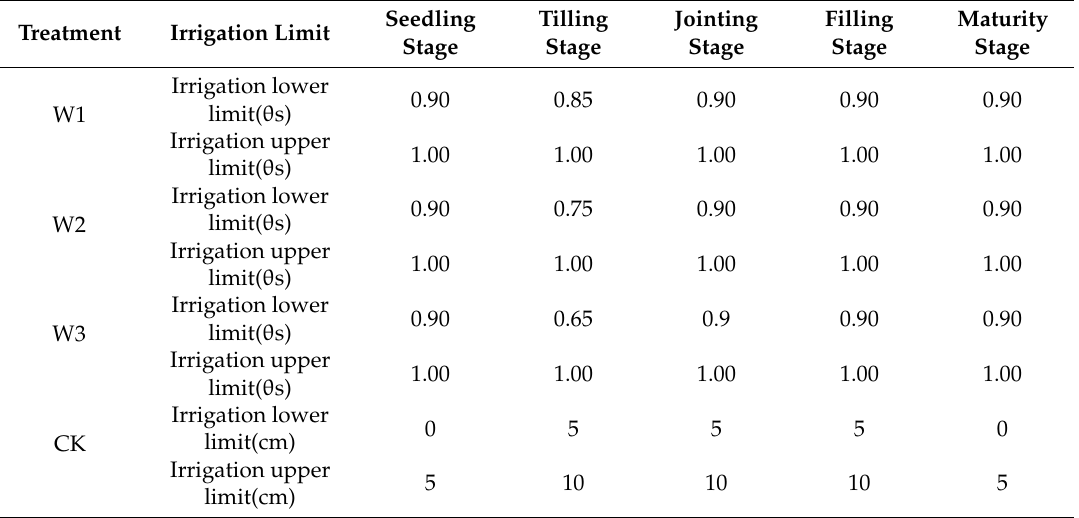
Table 2. Field water control standards for di ff erent irrigation treatments where θ s represents field water